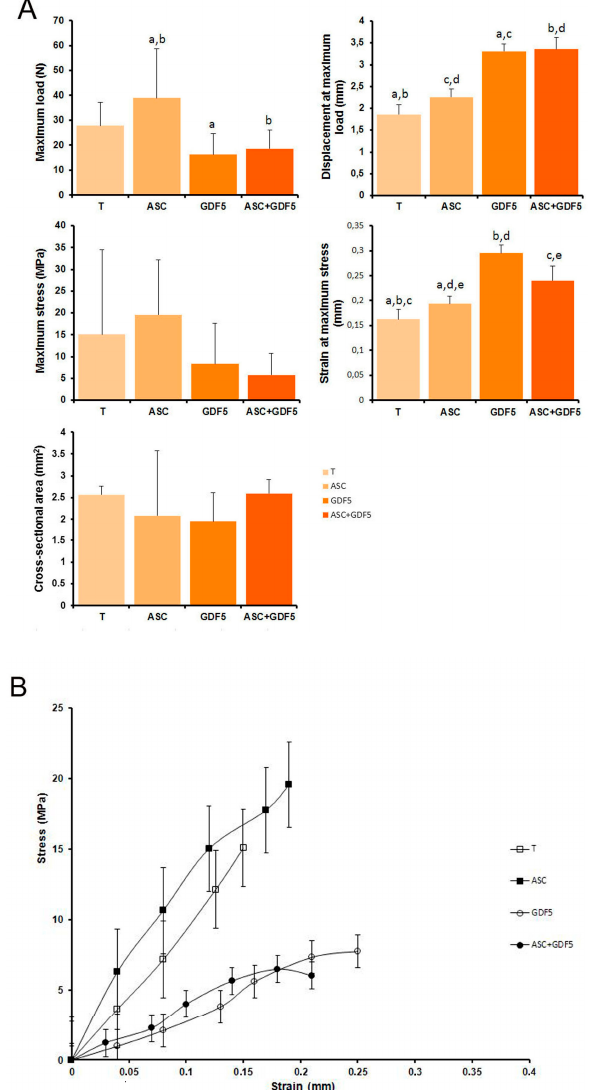
Figure 9. ( A ) Biomechanical properties of the tendons: Significant differences can be observed between the groups for the parameters of maximum load, displacement, and strain. The same letter between the groups corresponds to a significant difference between them ( p ≤ 0.001). ( B ) Stress-strain curve: Tendons treated with ADMSC presented lower deformation at higher stress in comparison to the other groups. Standard deviations are represented by vertical bars.